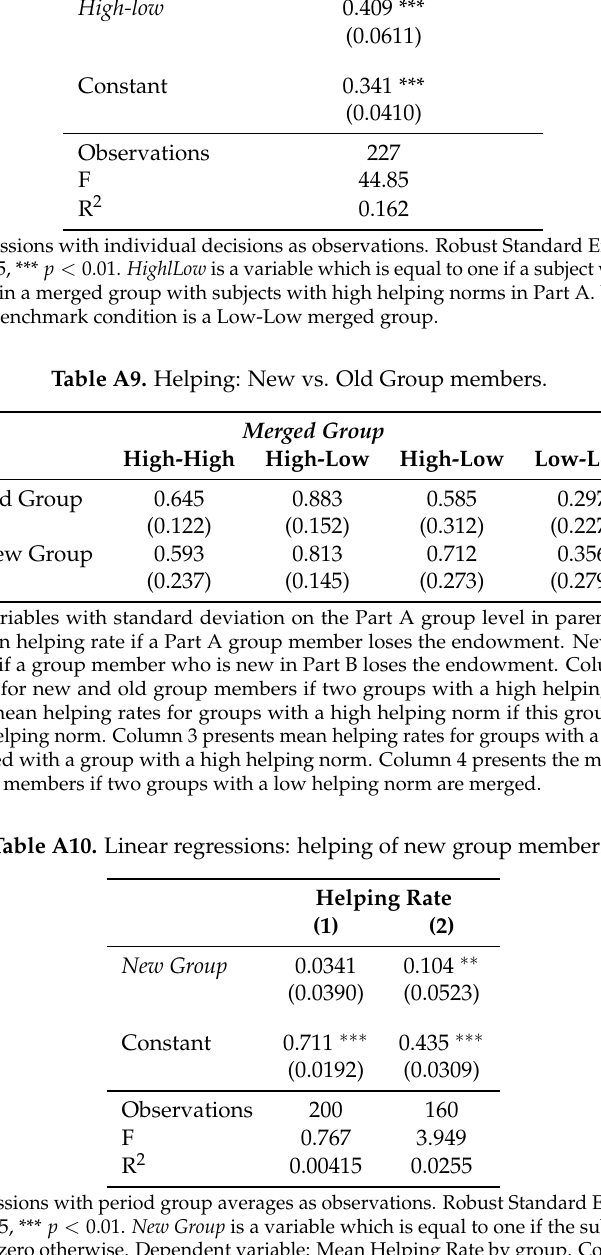
Table A11 highlights the group efficient outcomes. In each group, exactly three subjects need to help. If fewer subjects (or more in a group of eight) help, the efficient group payment is not